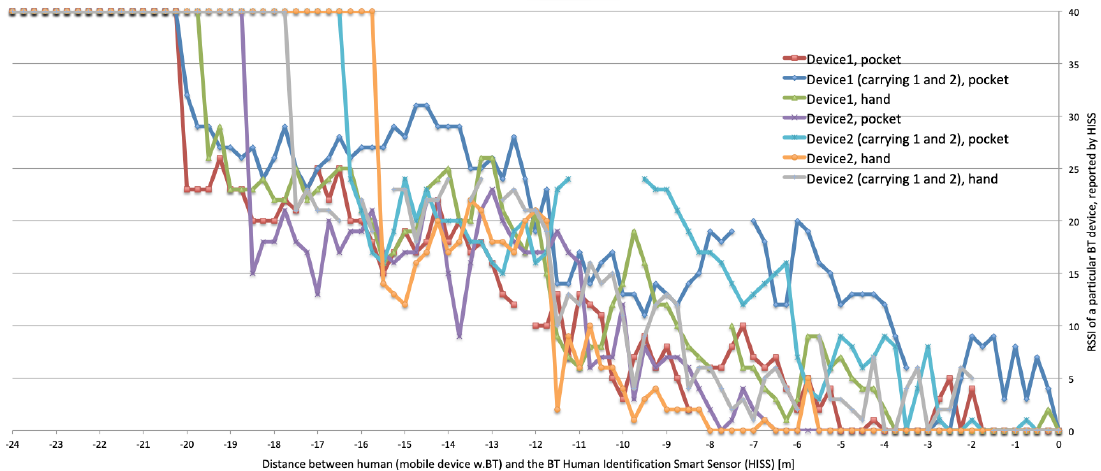
Figure 7. Bluetooth usability test—7 different test scenarios of a BT device carried towards the Bluetooth-based Human Identification Smart Sensor (BT HISS) node. X axis—distance in meters, Y axis—RSSI as a relative index (0 = best